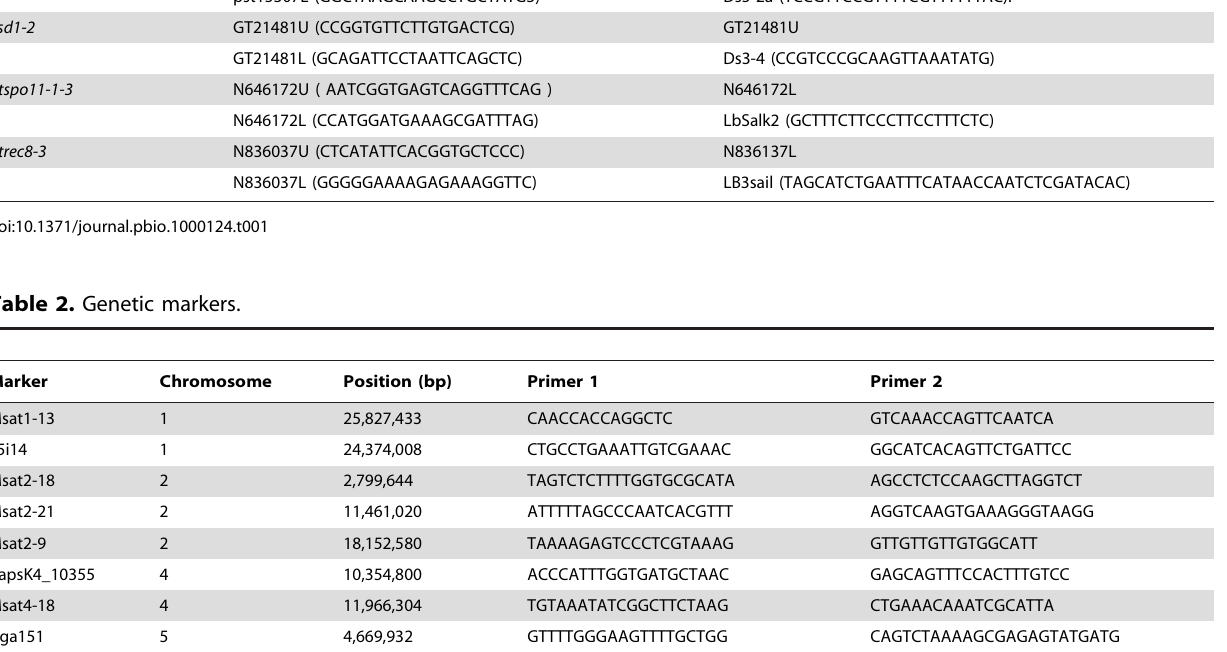
mutant Primers for Wild-type Allele Primers for Mutant